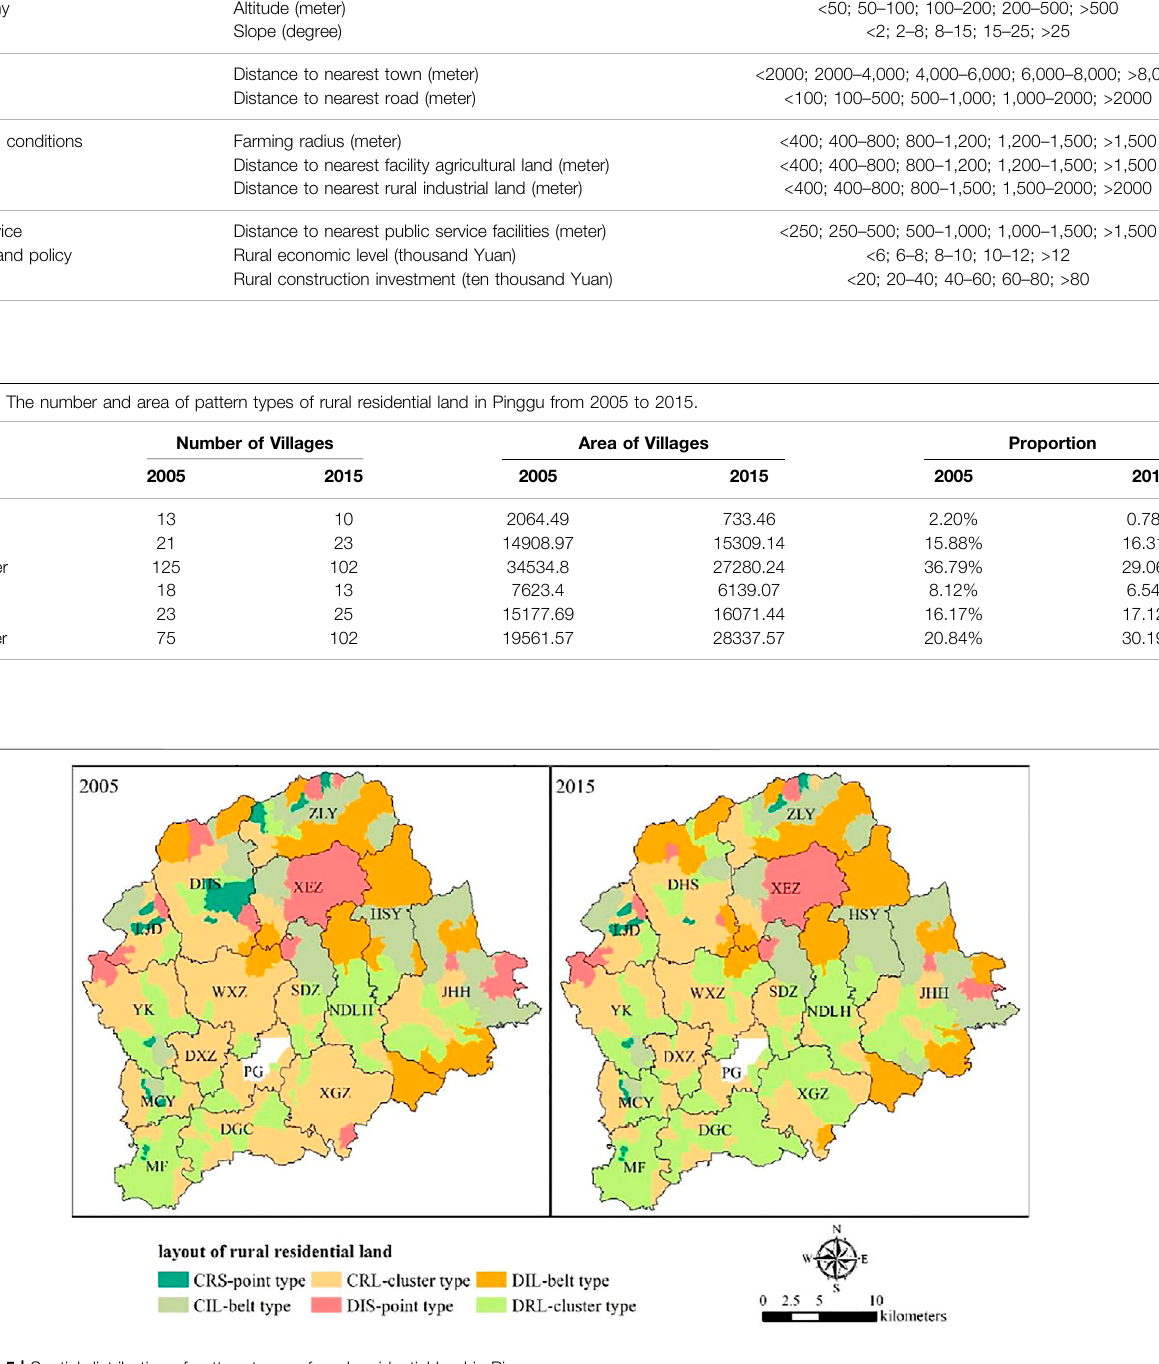
FIGURE 5 | Spatial distribution of pattern types of rural residential land in